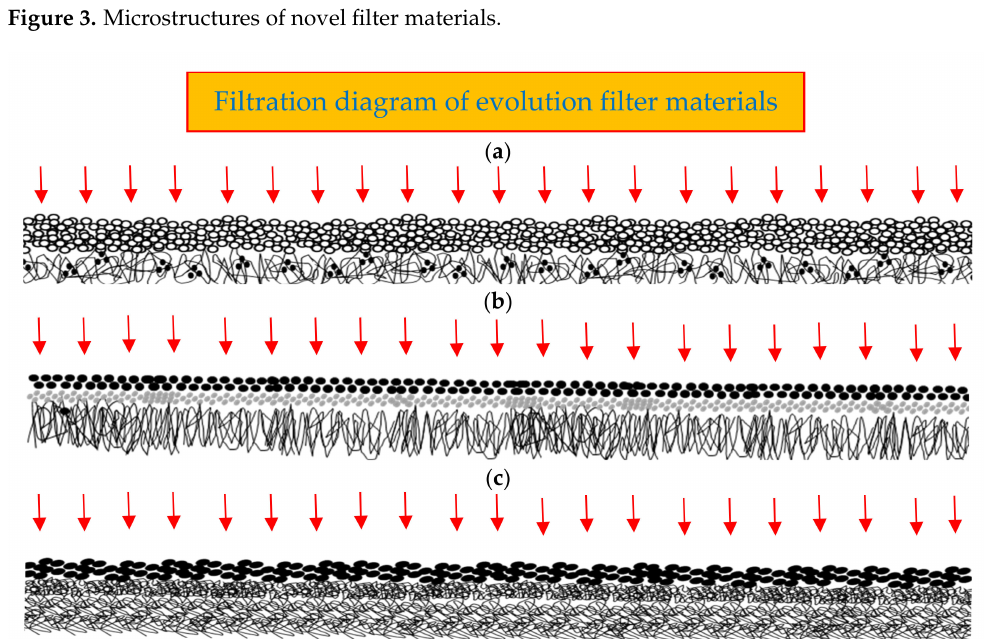
Figure 3. Microstructures of novel filter materials.